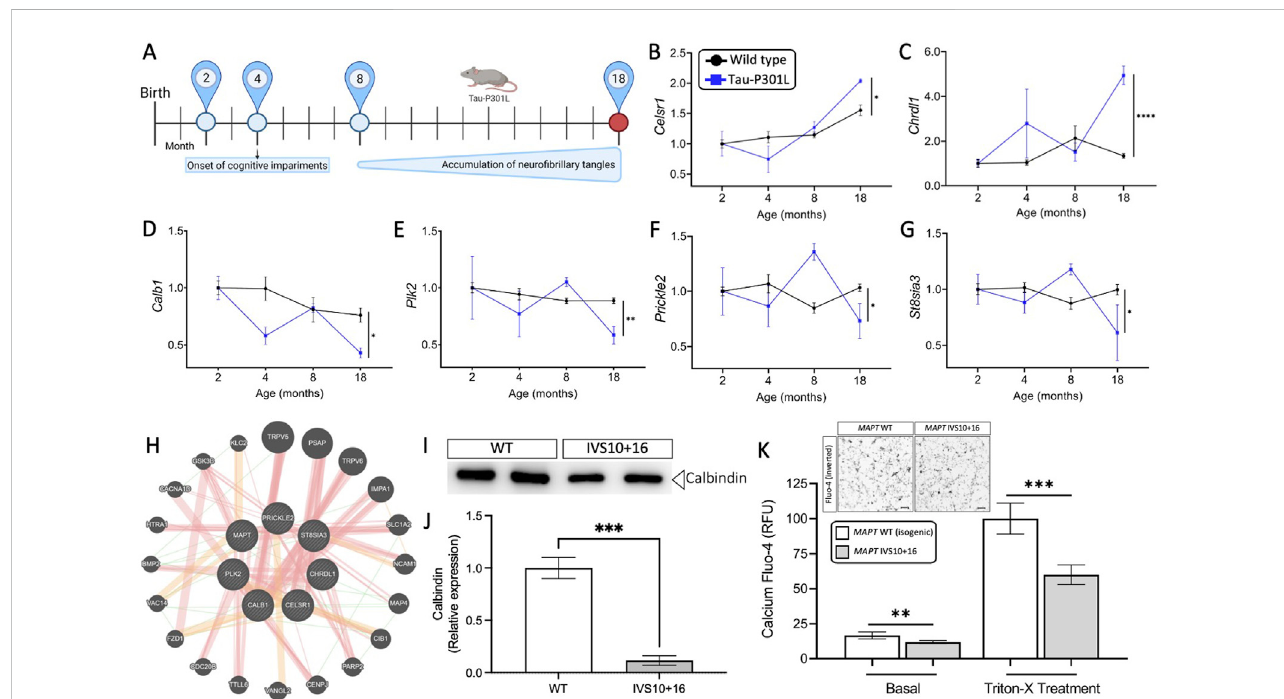
FIGURE 4 Genes altered in iPSC-neurons from MAPT mutation carriers are replicated in disease end-stage in the Tau-P301L tauopathy mouse model. (A) The expression of the 11 genes observed in iPSC-neurons were evaluated in the mouse model of tauopathy (Tau-P301L vs. wild type). Statistical comparisons re fl ect gene expression at disease end-stage (18 months old mice). (B – G) Expression of the six selected genes (2 up- and 4 down-regulated) in mice. Black circles,transgenicTau-P301Lmice;bluesquares,non-transgeniccontrolmice.Graphsshownormalizedgeneexpressionrelativeto2 monthsoldmice. The genes presented were selected based on: (I) the expression of the genes in the human cell models and in mice followed the same direction, and (ii) the differenceintheexpressionofeachgenein18-montholdcontrolsandtransgenicTau-P301Lmicewassigni fi cant.Statisticalanalyses(t-tests)werebasedon values normalized related to mice that were 2 months old. * p ≤ 0.05; ** p ≤ 0.01; **** p ≤ 0.0001. (H) Relatedness of the six selected genes dysregulated in human and mice, including the MAPT gene. The plot demonstrates the strong physical (orange nodes: 80.3%) and genetic interactions (green nodes 4.28%) betweenthequerygenesandgeneshavebeenrelatedtopathwayssuchasneurogenesis, behavior,learningormemory,andglutamatergicsynapse. Thesize ofthegene nodesisproportional to thedegree to which thegenesare related.Query genesare presented as stripeddark greyballs andother selected genes subjected to interaction are presented as dark grey balls without stripes. Physical (orange; 80.3%), predicted (yellow; 9.48%), and genetic (green; 4.28%) interactionsaredisplayedwithinthenetwork. (I – K) Calciumisdysregulatedin MAPT neurons.iPSC-neuronsfrom MAPT IVS10+16andisogeniccontrolwere cultured for 42 days and evaluated for calbindin 1 protein and intracellular calcium levels. (I) Immunoblot for calbindin 1 protein levels. (J) Quanti fi cation of calbindin 1 protein levels. (K) Inset, inverted fl uorescent imaging representing the calcium concentration in iPSC-neurons treated with Fluo-4 Direct